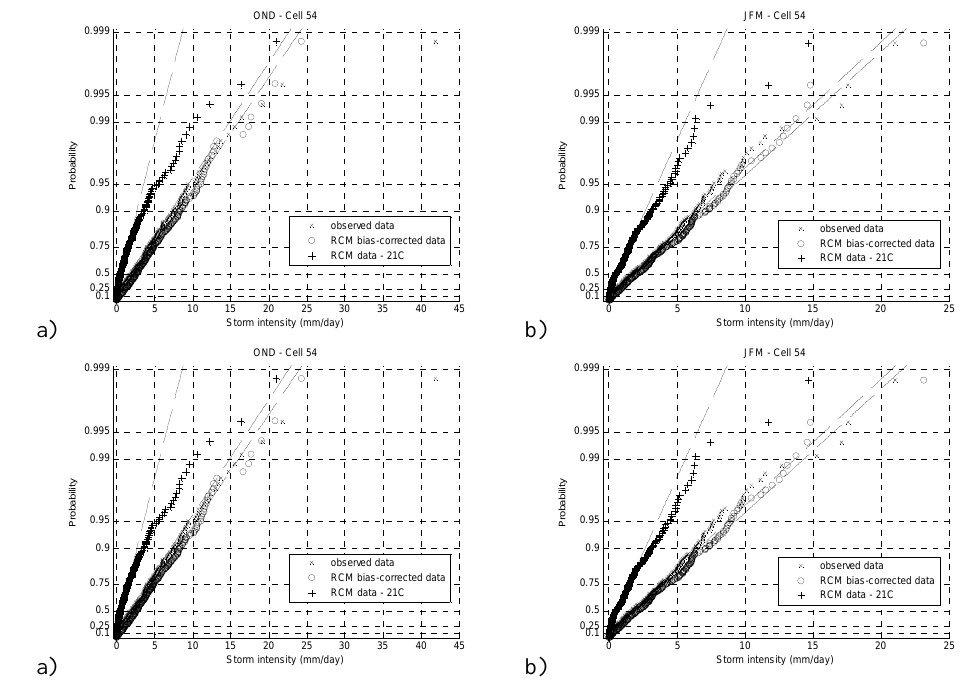
Fig. 8. Exponential probability plots of the daily storm intensities obtained for a grid-cell using the PRP stochastic model for autumn (a) , winter (b) , spring (c) and summer (d) . The dashed lines represent the theoretical distributions estimated for the reference observations, the row RCM data, and RCM bias-corrected data for the 21st Century respectively.